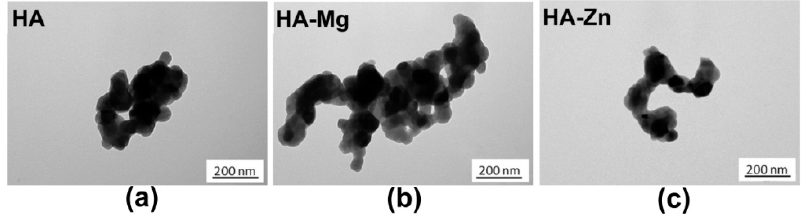
Figure 1. Transmission electron microscope (TEM) images of the obtained powders: ( a ) hydroxyapatite (HA), ( b ) HA substituted with magnesium (HA-Mg), and ( c ) HA substituted with zinc (HA-Zn) (scale bar = 200 nm).